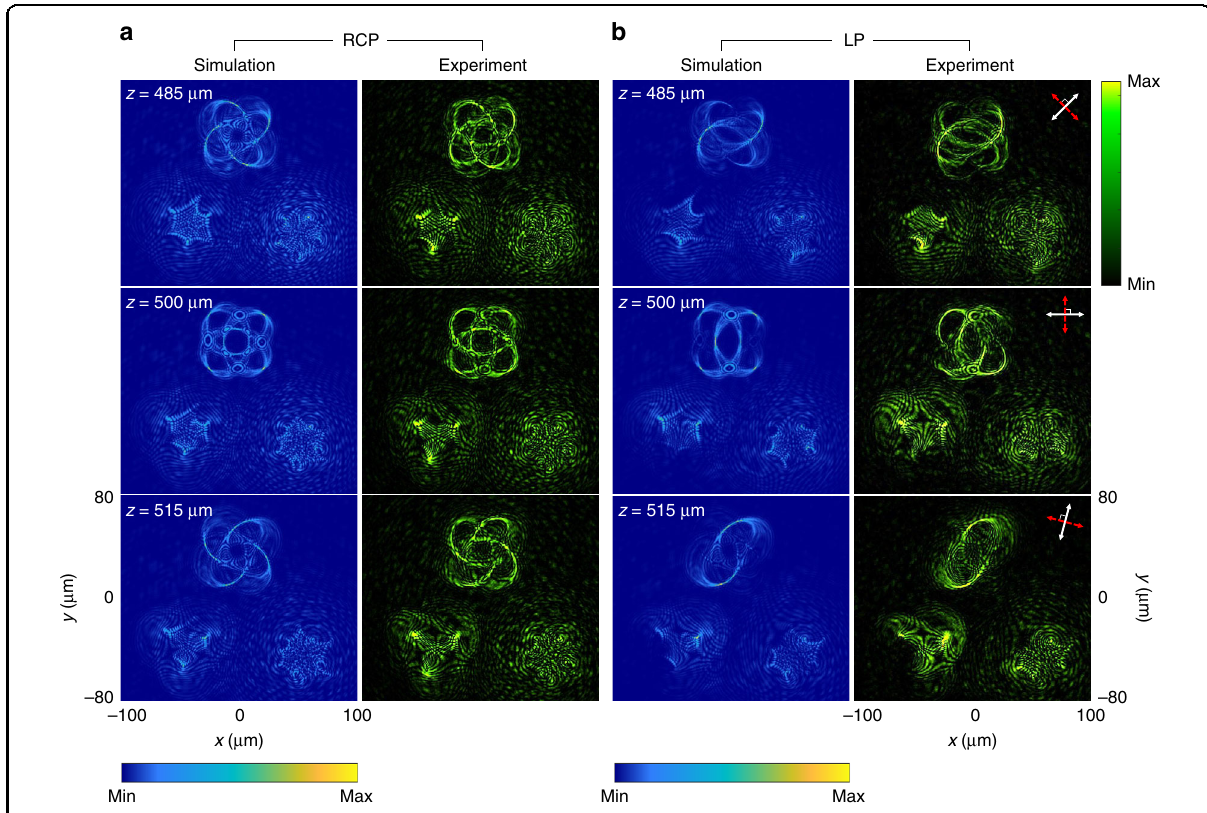
Fig. 5 Simulation and experimental results of the selected 3D polarization knots at λ = 575 nm. a The intensity distributions at different observation planes upon the illumination of RCP light. b Polarization structure detection with the same detection method as that in Fig.